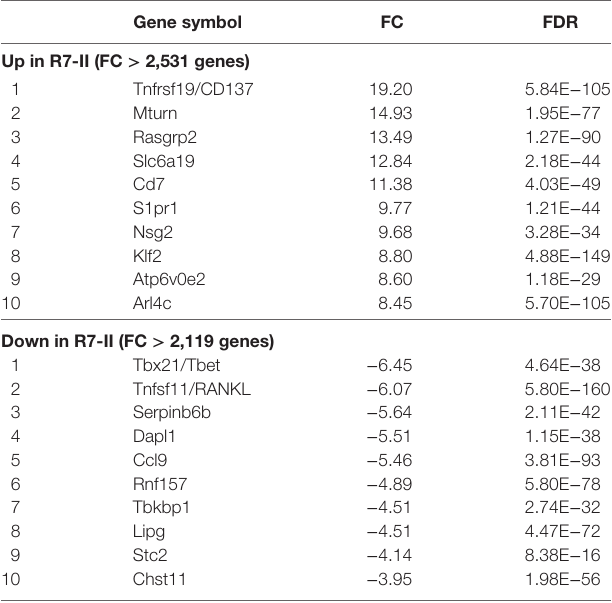
Table shows top 10 up- and downregulated genes in R7-II samples as compared with R7-I and R7-III samples upon activation, where only genes differentially expressed in R7-II vs R7-I and R7-II vs R7-III comparisons but similar expression between R7-I and R7-III were included. For each gene in the table, fold change (FC) and false discovery rate (FDR) are shown for R7-II vs R7-III comparison.